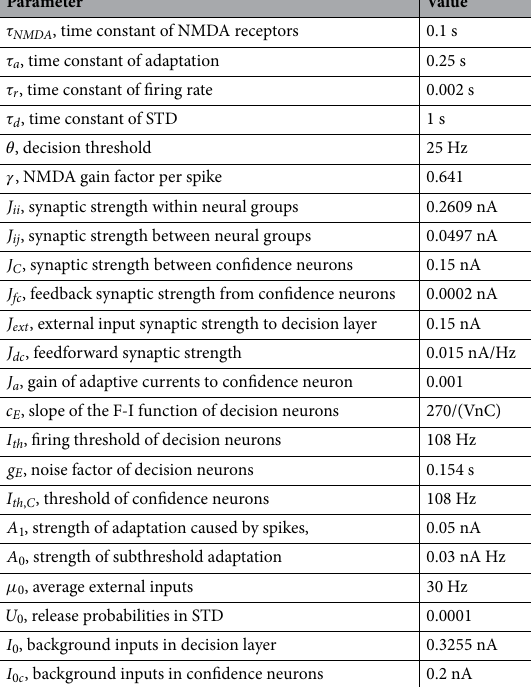
Table 1. Parameters used in the